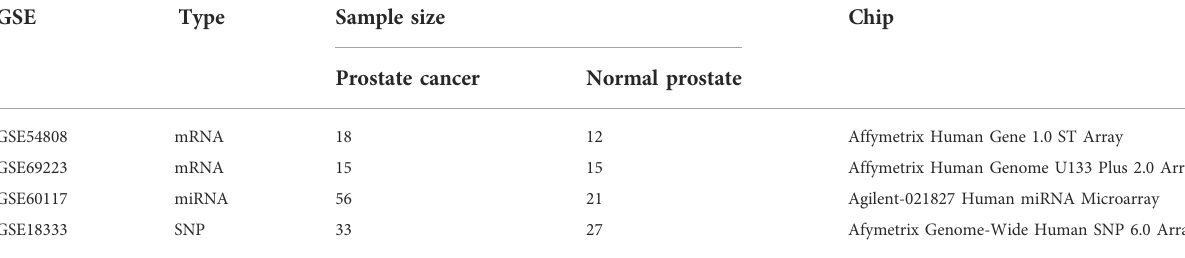
TABLE 1 Details of microarray datasets from GEO